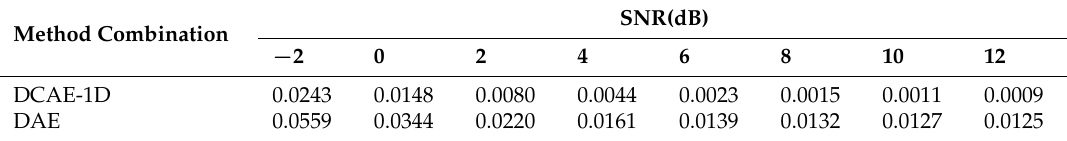
Figure 7. Reconstruction errors of DCAE-1D and DAE under different SNR. Table 5. Reconstruction errors of DCAE-1D and DAE under different SNR.